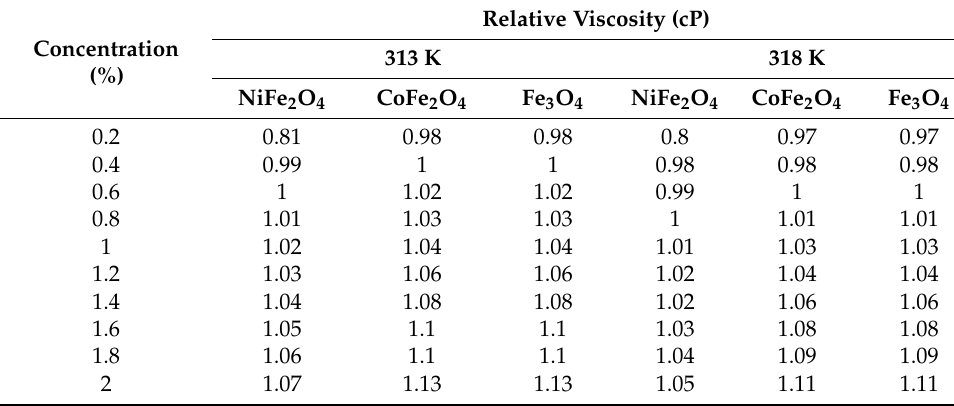
Table 3. Values of relative viscosity of NiFe 2 O 4 , CoFe 2 O 4 and Fe 3 O 4 NFs.